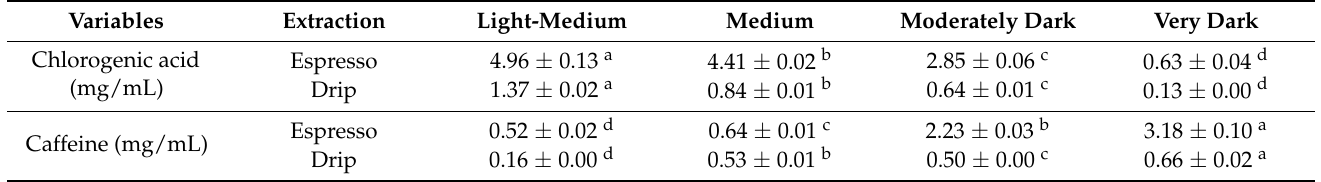
Table 4. The contents of chlorogenic acid and caffeine in coffee